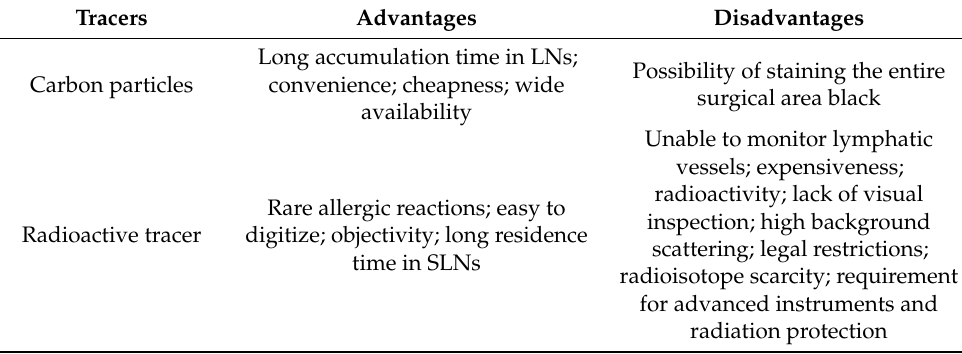
Table 1. Cont. Tracers